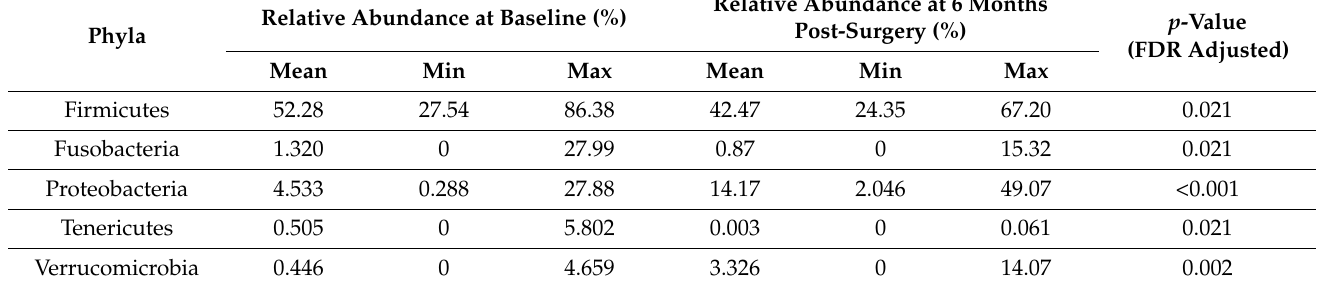
Table 3. Changes in relative abundances of phyla for all patients from baseline to 6 months post- surgery ( n = 28). Only significant results ( p < 0.05) are listed.